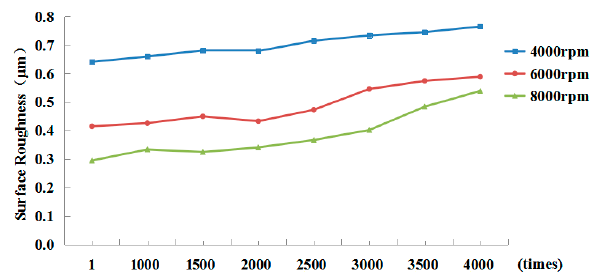
Figure 10. Workpiece surface roughness.